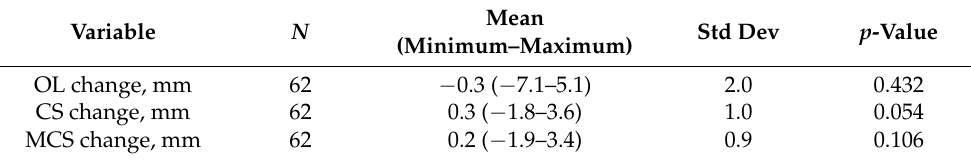
Table 4. Differences in radiographic outcomes for the post-SR